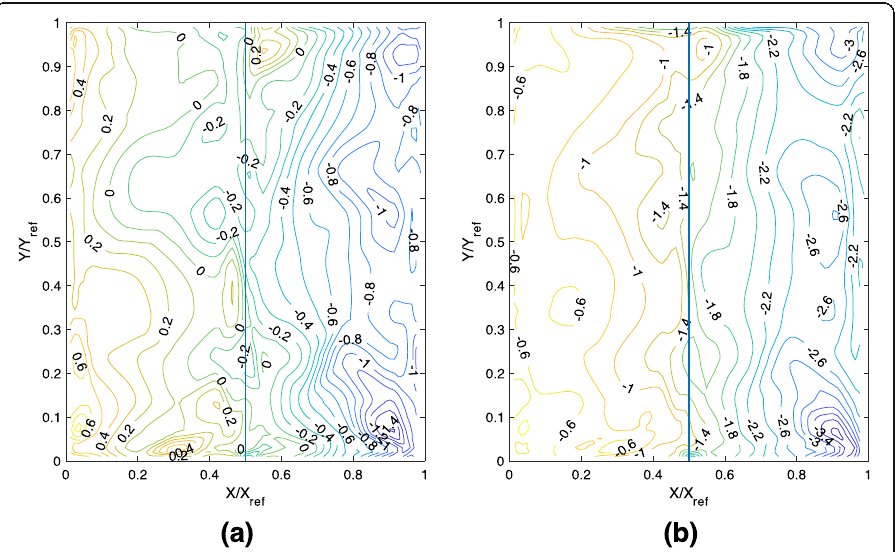
Fig. 18 Contours of roof pressure coefficients ( θ = 90 deg.), for the 4.5 ft. parapet case: ( a ) mean Cps, and ( b ) 95% quantile peak